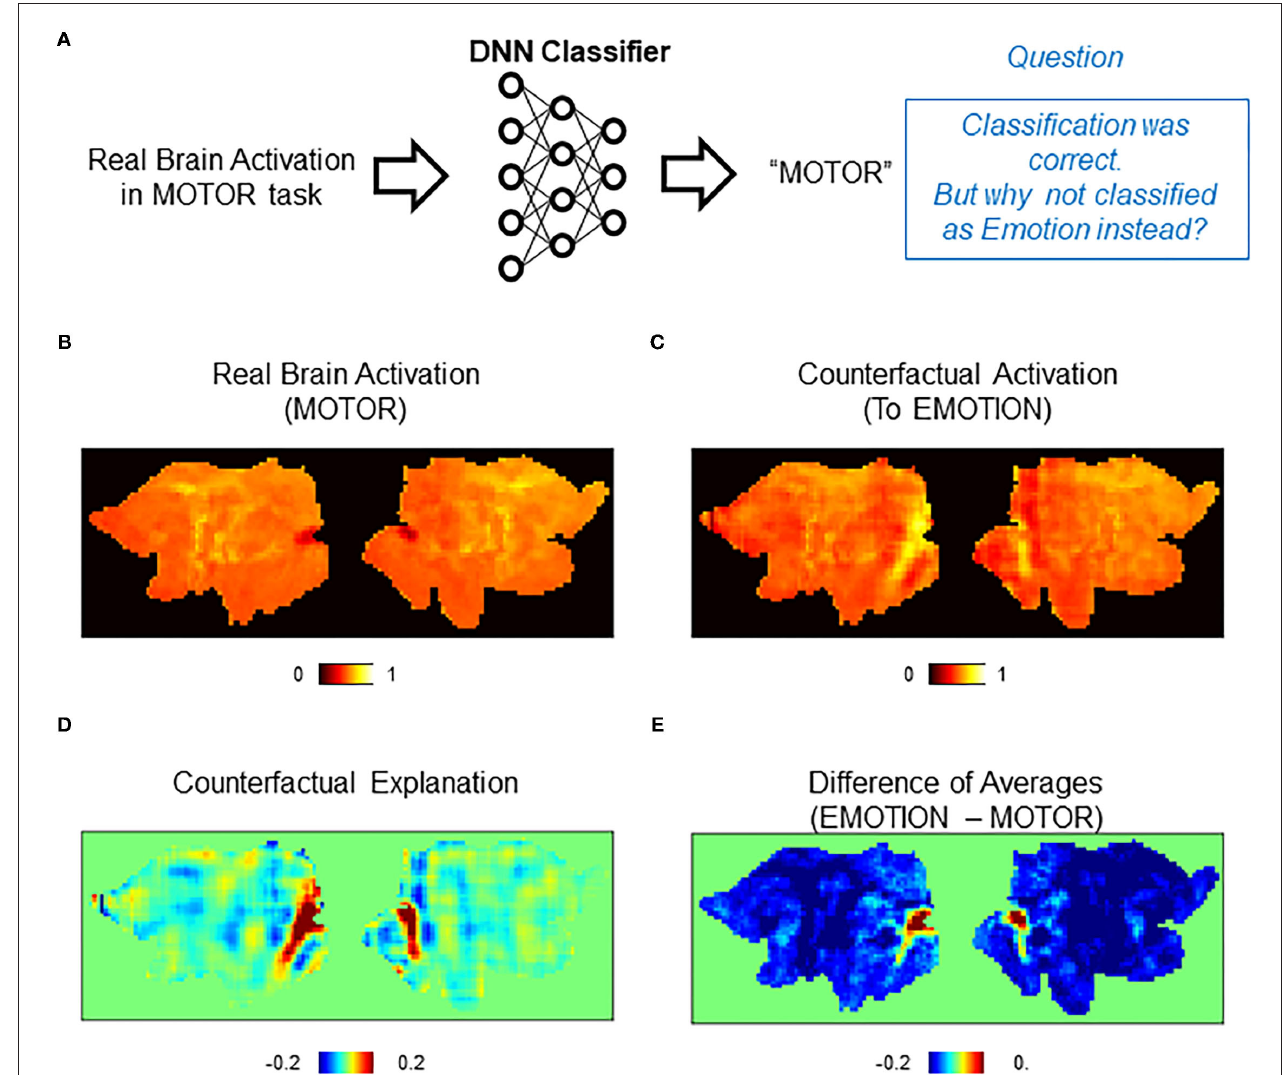
FIGURE 4 | Counterfactual explanation of correct classification. (A) Schematics of the question asked in this analysis. In this example, the DNN classifier correctly assigned a “MOTOR” label to a real brain activation in the MOTOR task. Here, we want to interrogate this correct decision. Specifically, we ask a question “why did the classifier assign MOTOR instead of EMOTION?” (B–E) Examples of counterfactual explanation. (B) A population average map of real brain activation in the MOTOR task. (C) A population average map of counterfactual activation obtained by transforming the map in (A) to EMOTION. Transformation was conducted for each activation map and then averaged across the population. (D) Pixel-by-pixel subtraction of maps in (B) and (A) that serves as counterfactual explanation. This map explains why the map was classified as MOTOR but not EMOTION. (E) Simple difference between the average of real activations in the EMOTION and MOTOR